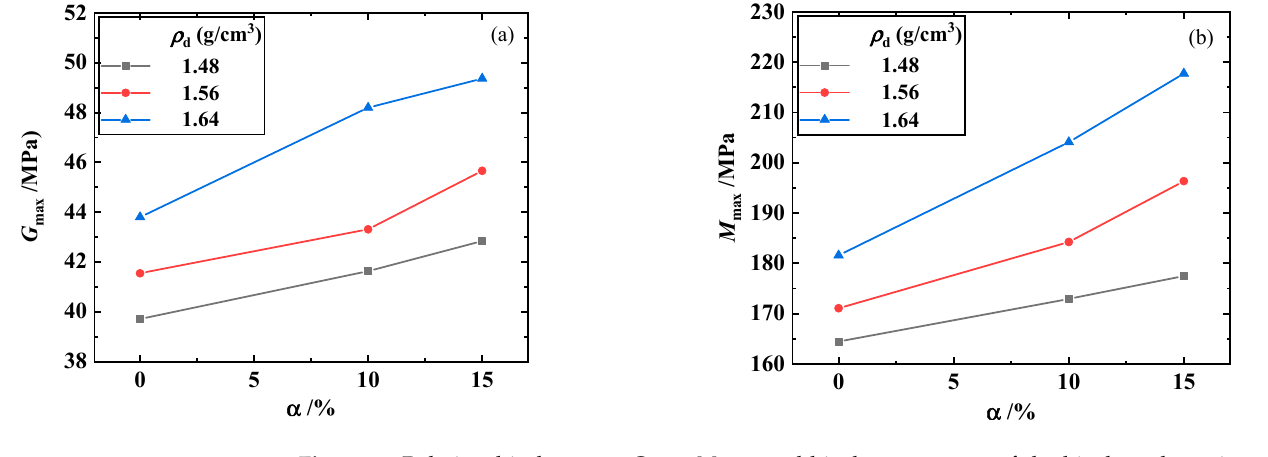
Figure 8. Relationship between G max , M max , and biochar content α of the biochar–clay mixture: ( a ) G max – α ; ( b ) M max – α .